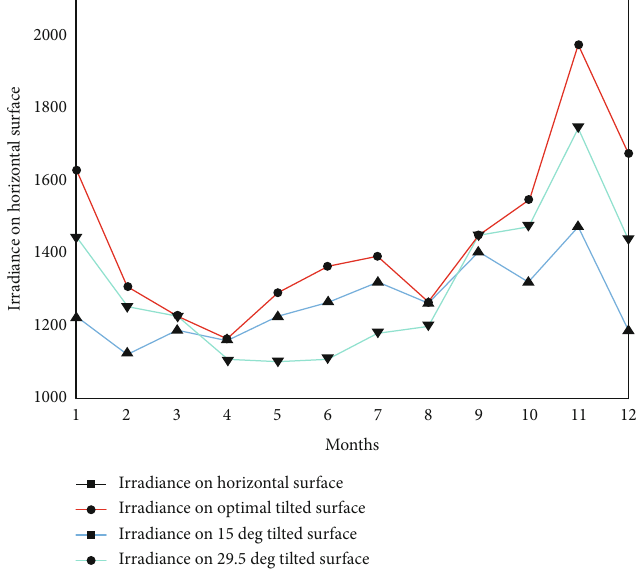
Figure 5: Comparison of irradiance on di ff erent tilt angles.